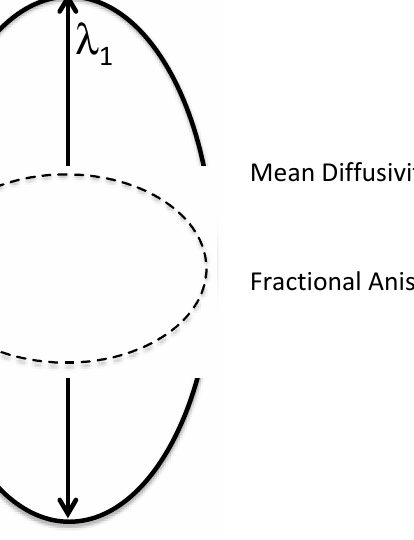
Figure 9. Illustration of 3D ellipsoid and formulas for mean diffusivity (MD) and fractional anisotropy (FA). The 3D ellipsoid is characterized with three eigenvectors that define the axes and with three associated eigenvalues ( λ ) that define the